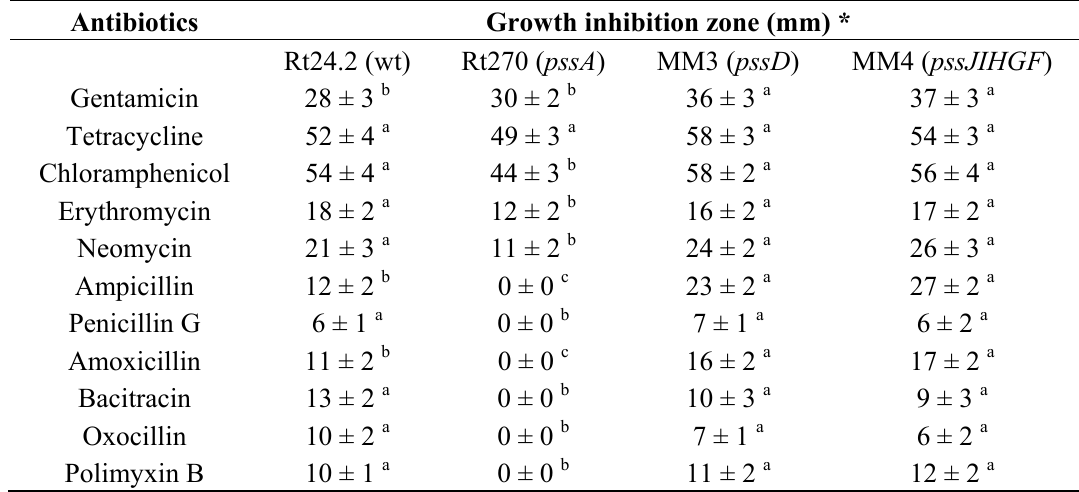
Table 4. Sensitivity of the wild-type Rhizobium leguminosarum bv. trifolii 24.2 and the pssA mutant Rt270 strains to various